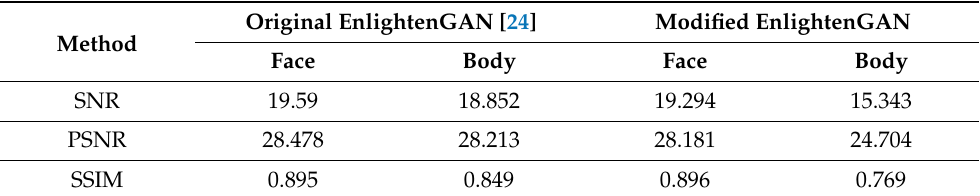
Figure 7. Comparisons of output images by original EnlightenGAN and modified EnlightenGAN. ( a ) Original normal illumination image. ( b ) Low-illumination image. Output images by ( c ) original EnlightenGAN, and ( d ) modified EnlightenGAN. Table 7. Performance comparisons with enhanced images by original EnlightenGAN or modified EnlightenGAN.